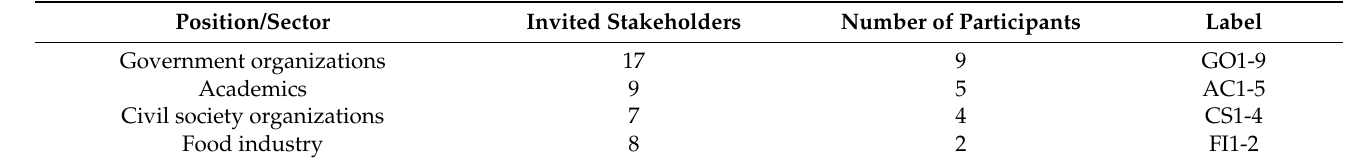
Table 3. Description of informants recruited for interviews, September 2021–January